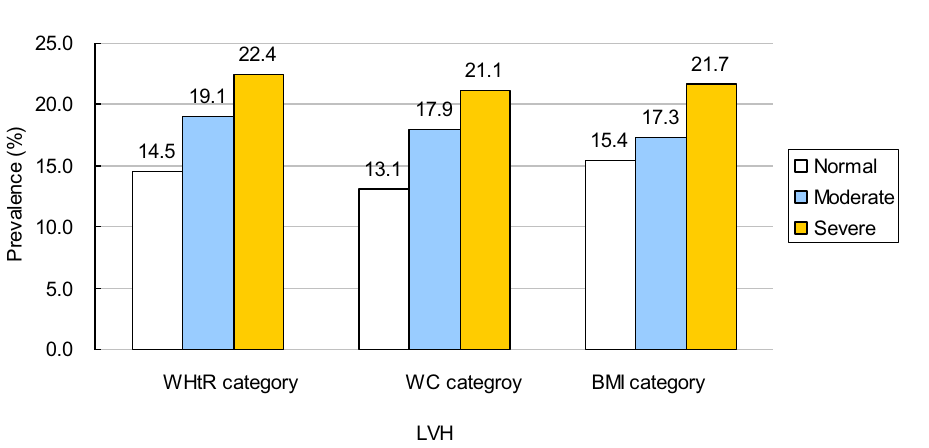
Figure 1. Prevalence of LVH across three categories (normal, moderate, and severe) of each of three adiposity indices. Notes Normal, moderate, and severe status for WHtR was defined using 0- < 0.45, 0.45- < 0.50, and ≥ 050, respectively; for WC defined using < 75th percentile, 75th—< 90th percentile, and ≥ 90th percentile, respectively; for BMI defined using < 85th percentile, 85th—< 95th percentile, and ≥ 95th percentile,